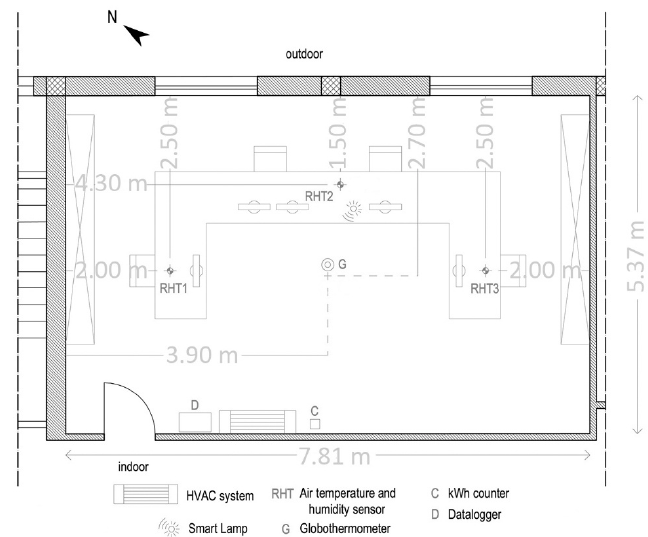
Figure 6. Office plan and sensors distribution.